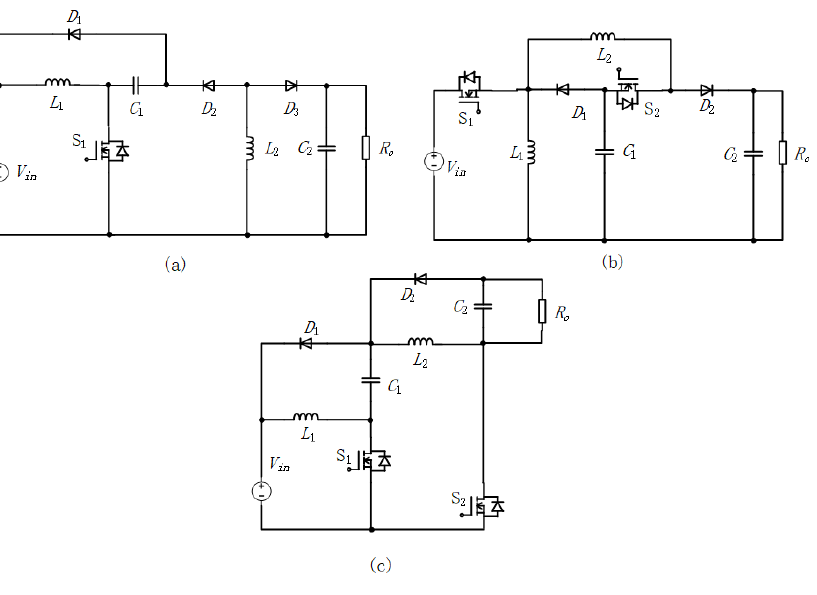
Figure 22. Basic quadratic DC-DC converters. ( a ) Basic structure. ( b ) Improved structure.